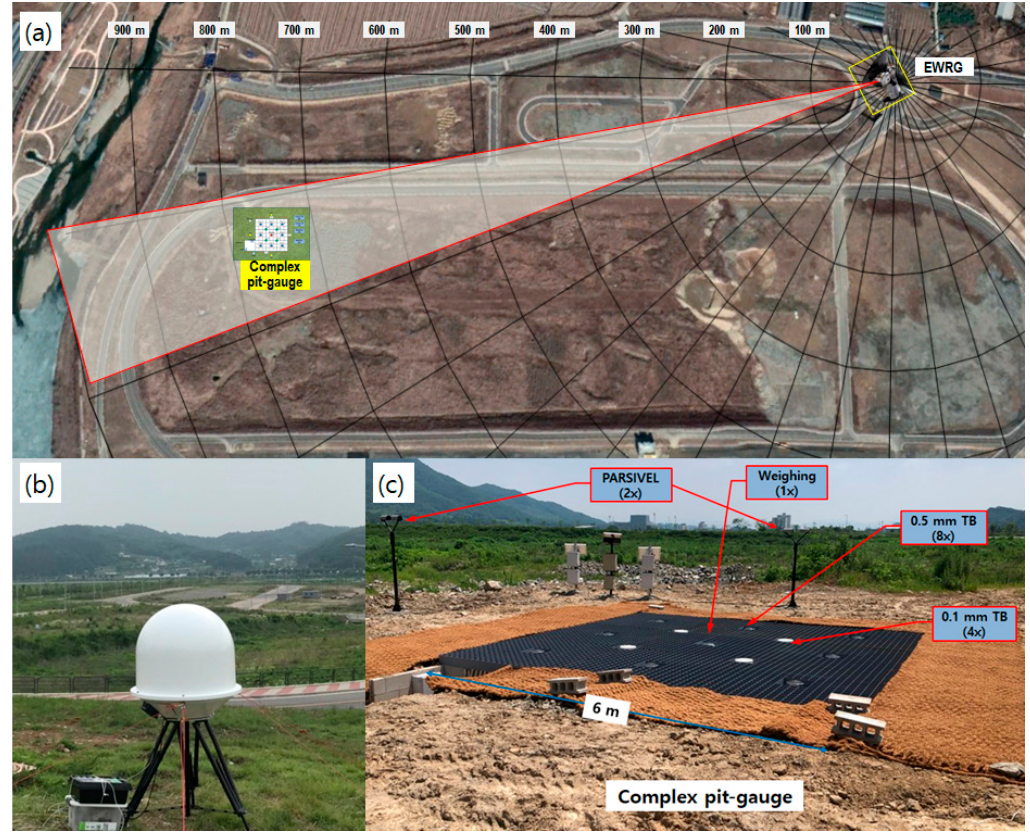
Figure 14. EWRG testbed at Yeoncheon SOC center. ( a ) Layout of the EWRG and complex pit-gauge; ( b ) EWRG installation; ( c ) Pit-Gauge and Parcivel installation. On 26 July 2019, heavy rain (event 4), caused by a strong seasonal rain front, hit the central and northern parts of the Korean Peninsula, causing a downpour exceeding 100 mm/h. EWRG observation images taken at 07:08 on 26 July 2019, are shown in Figure 15 (from left to right: reflectivity, correlation coefficient, and differential phase shift). Figure 16a shows the instantaneous average rainfall intensity (mm/h) estimated by the EWRG and the rainfall intensity obtained by the ground instruments, and Figure 16b compares the cumulative rainfall (mm). In this figure, a comparison of the results of the pit-gauge (installed approximately 600 m from EWRG) and the EWRG show that, for this event, the average rainfall estimates of the EWRG were almost identical to the rainfall measured at the pit-gauge. However, as with the Geoje event, the observation results for this event demonstrated that the rainfall intensity estimation of the Parsivel disdrometer tends to be slightly underestimated.